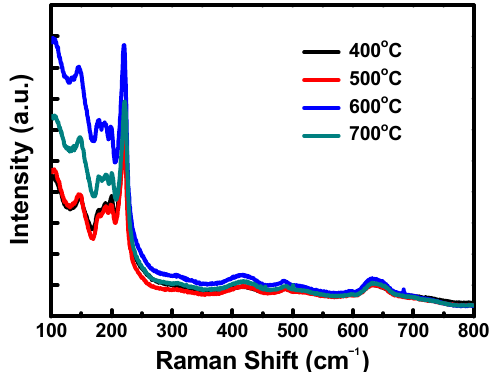
Figure 4. Raman spectra of the Cu 2 O counter electrodes sintered at various temperatures.